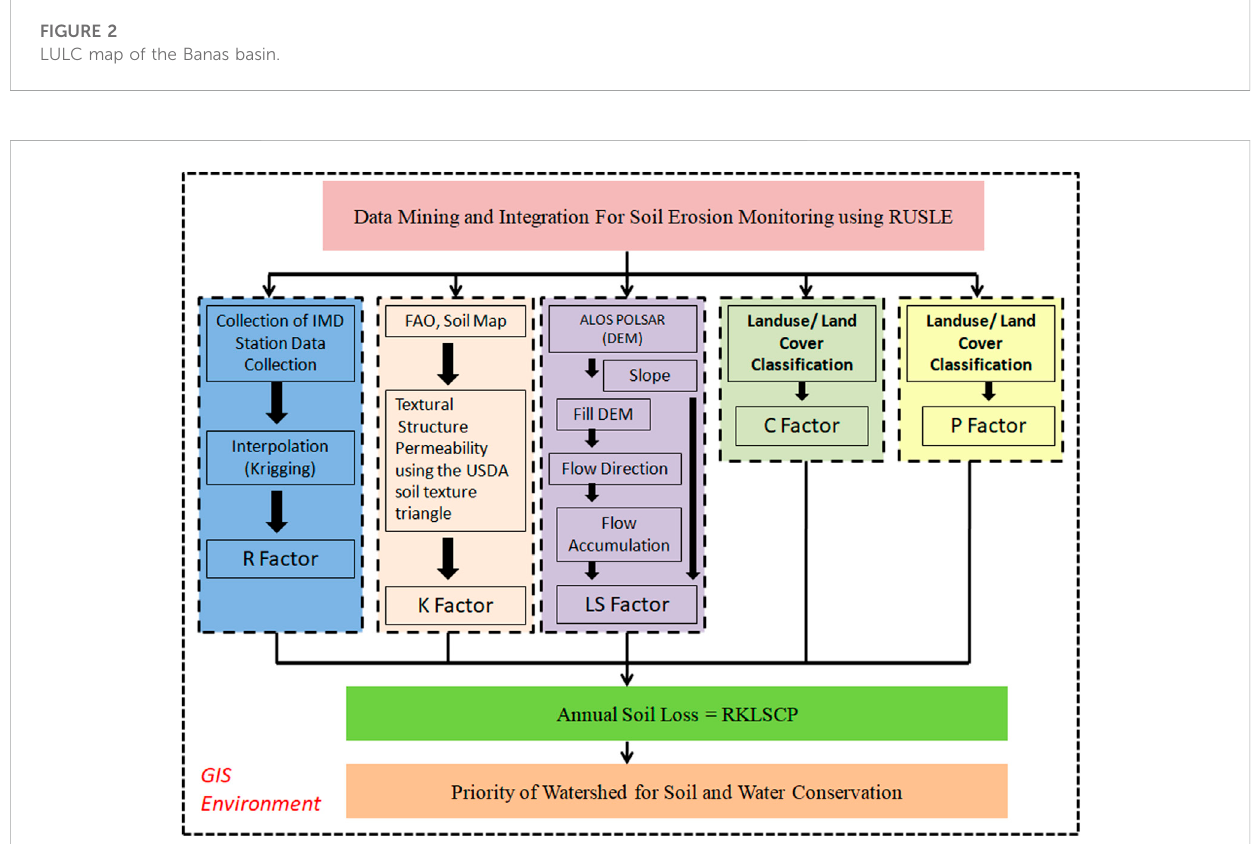
FIGURE 2 LULC map of the Banas basin.